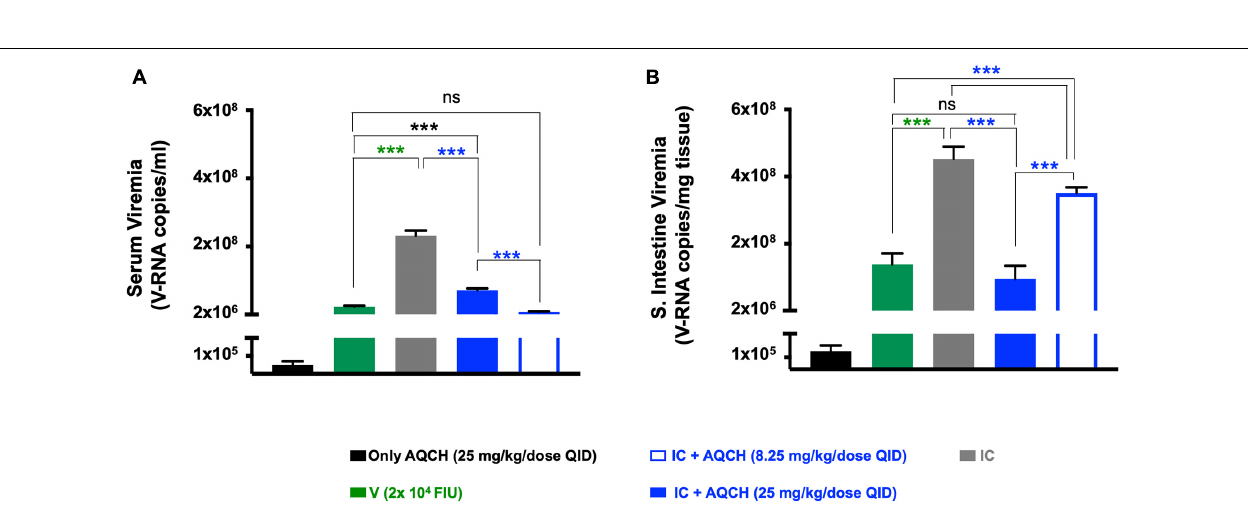
FIGURE 6 | Serum and intestinal viral inhibition by AQCH in secondary DENV infection: AG129 mice ( n = 3) inoculated with DENV-2 S221-4G2 IC to establish secondary dengue infection were orally fed with either 25 mg/kg QID (blue solid bar) or 8.25 mg/kg QID (blue empty bar) of AQCH. Serum samples were withdrawn on day 4, and mice were killed to collect small intestinal tissue. Serum viremia levels (A) and small intestinal viral load (B) were determined using SYBR green-based real-time PCR. “Only AQCH,” “V,” and “IC” control groups are shown in black, green, and gray bars, respectively. Signals detected in “Only AQCH” group (black bars) considered as real-time quantitative polymerase chain reaction background, as this group was fed with AQCH (25 mg/kg QID) only and not infected with virus. Statistical differences between groups are presented on the top of bar graphs, ns, not significant ( p ≥ 0.05), ***very high significant difference ( p < 0.0001).